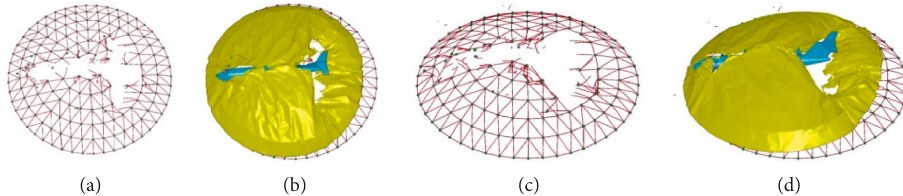
Figure 9: Deformations in the reticulated dome under lateral impact at different velocities. (a) Main bars after 80m/s impact. (b) Structure after 80m/s impact. (c) Main bars after 120m/s impact. (d) Structure after 120m/s